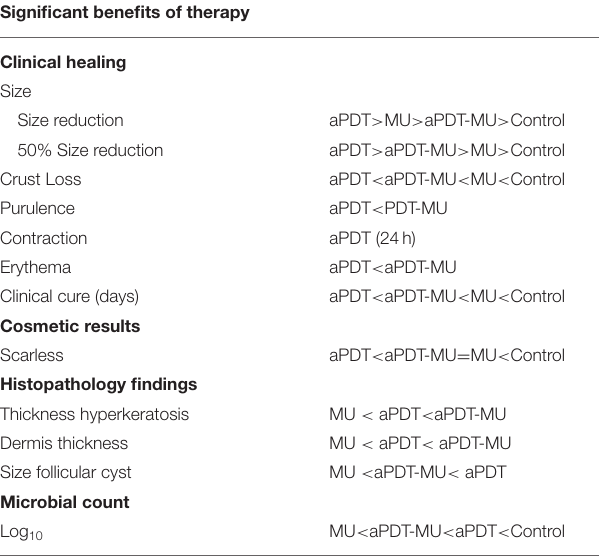
TABLE 1 | Ranking of the different treatments for the statistically clinical, cosmetic, histological, and microbiological variables. Significant benefits of therapy